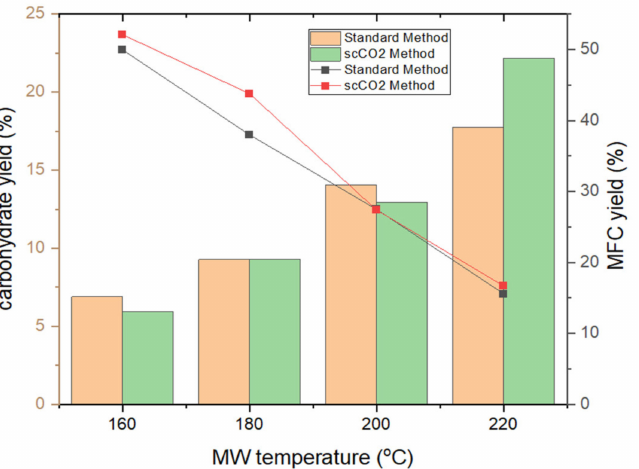
Figure 3. MFC yield (line chart) and carbohydrate yield (bar chart) of standard and supercritical treated microalgal biomass at different microwave temperatures. NB. ‘Standard’ refers to without any scCO 2 pretreatment.